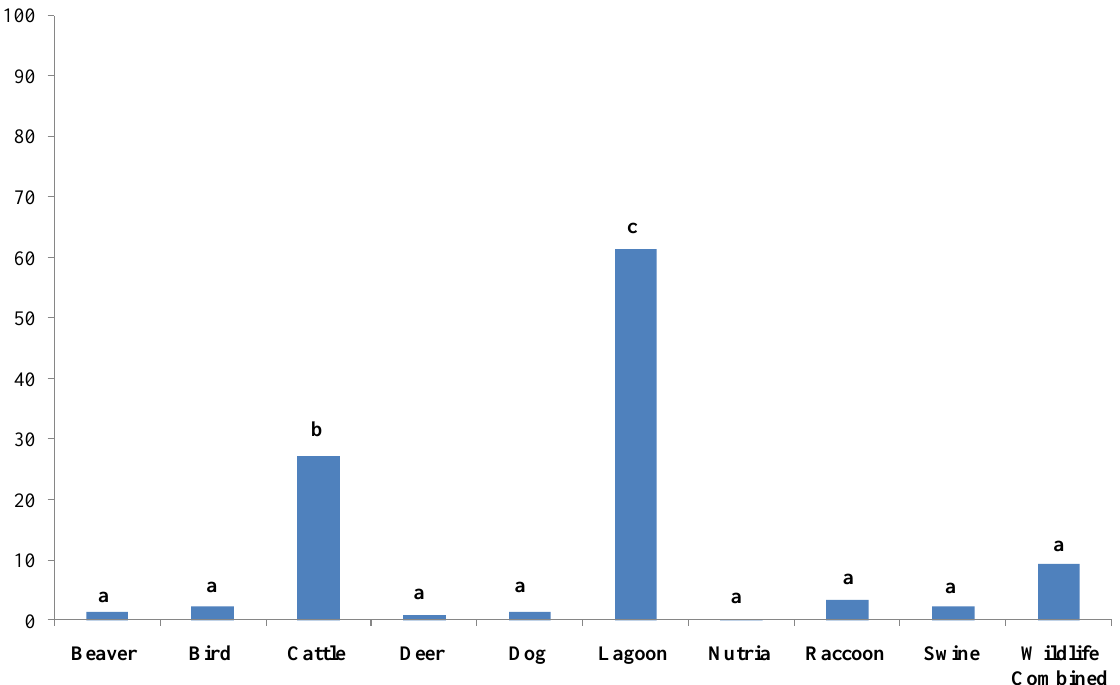
Figure 5. Host source identification of E. coli isolates (n = 1,961) from the surface waters of Six Runs Creek.